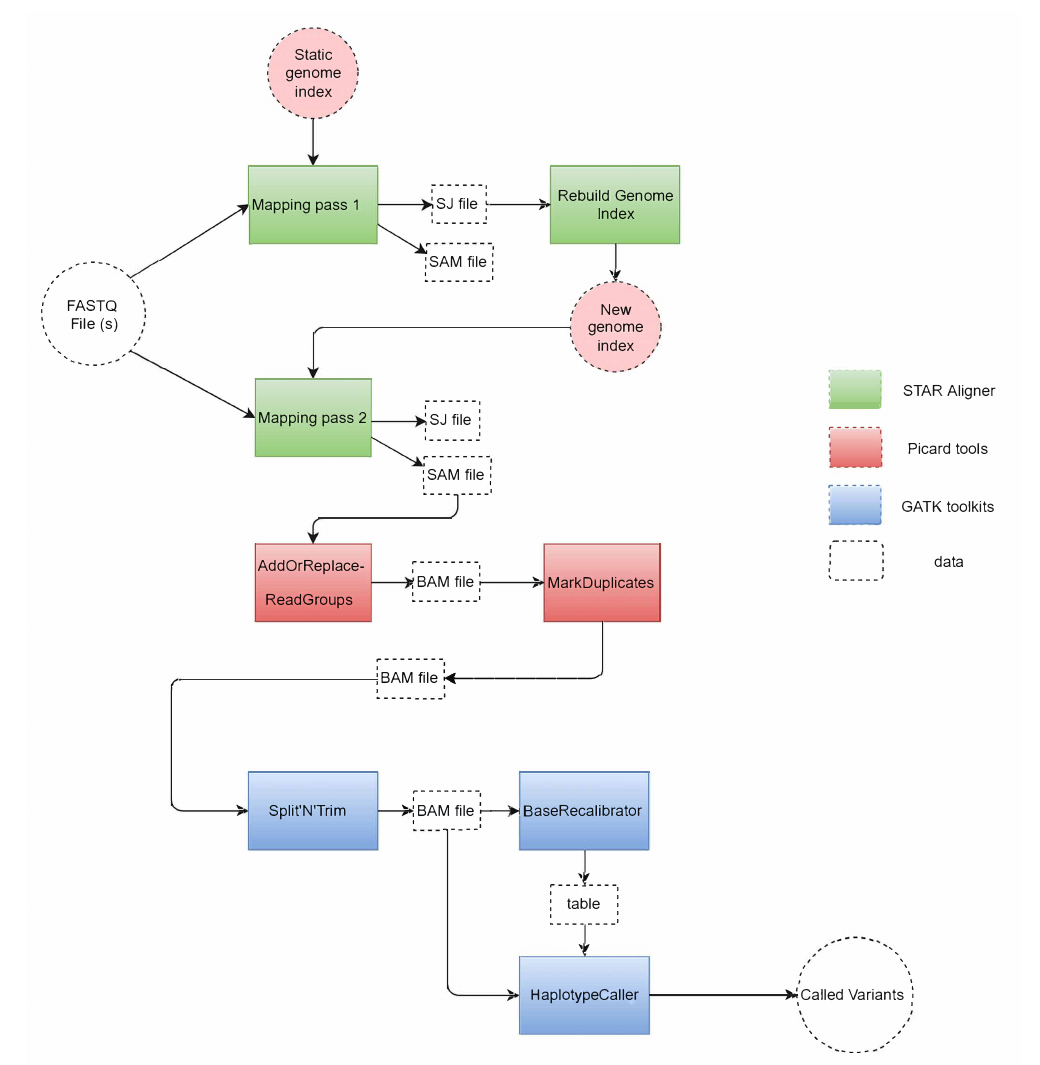
Figure 1. Tools used in the GATK RNA-seq pipeline and the way they process the data from input to